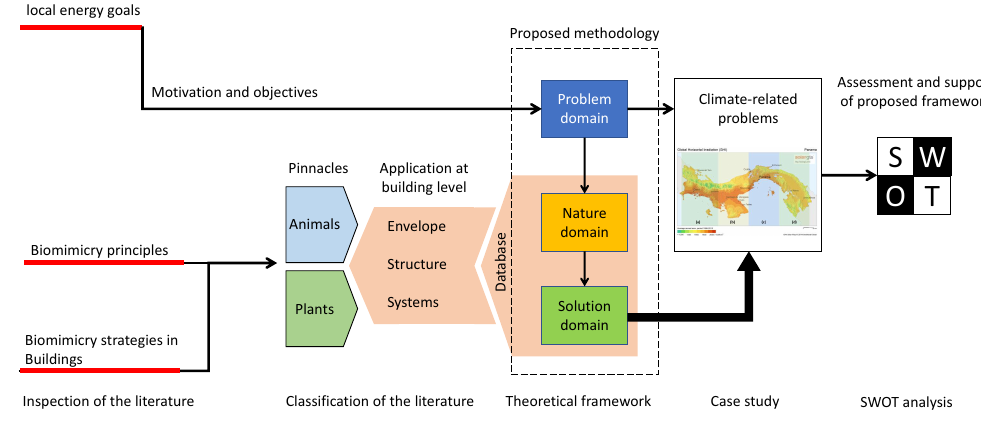
Figure 2. Schematic representing the structure of the